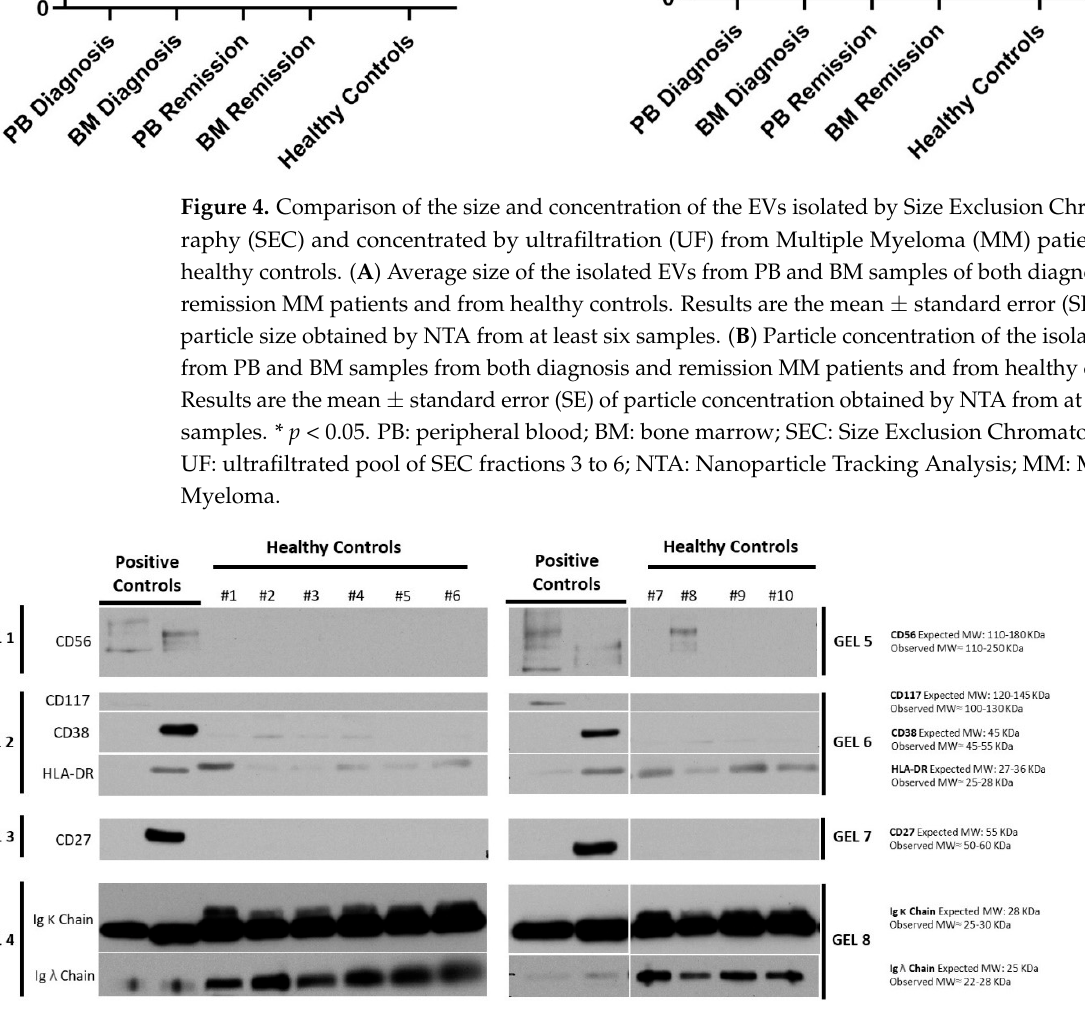
Figure 5. Analysis of Multiple Myeloma (MM) and Minimal Residual Disease (MRD) markers in EVs from the peripheral blood (PB) of healthy donors. Different markers of MM and MRD were analyzed by WB in the ultrafiltrated pool of SEC fractions 3 to 6 (UF) from the PB of 10 healthy donors. The UF from two MM patients was used as positive controls (left side of the blots). The molecular weight (MW) of the bands is shown in kDa on the right side of the blots. MM: Multiple Myeloma; MRD: Minimal Residual Disease; PB: peripheral blood; BM: bone marrow; SEC: Size Ex- clusion Chromatography; WB: Western Blot; UF: ultrafiltrated pool of SEC fractions 3 to 6. The absence of MM markers in EVs from healthy controls further suggests that mark- ers such as CD38, CD56, CD117, and CD27 are suitable for use as biomarkers of MM or in response monitoring of MRD.